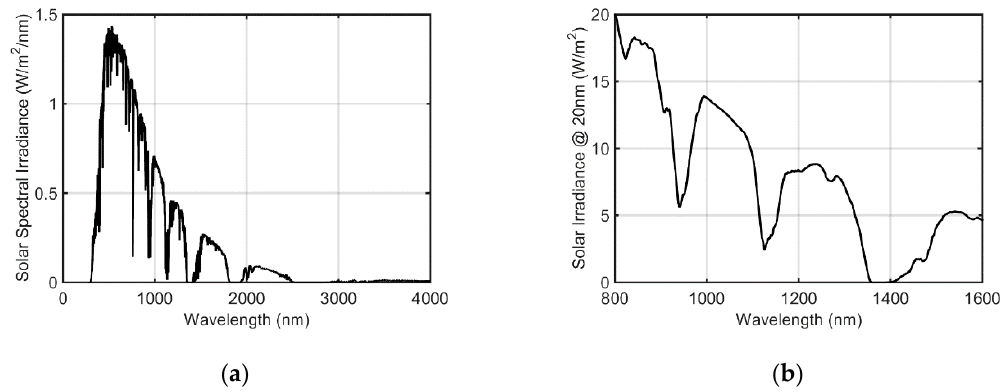
Figure 2. ( a ) Solar spectral irradiance (direct normal and circumsolar at AM 1.5) plotted, with permission, from G173-03 Standard Tables for Reference Solar Spectral Irradiances: Direct Normal and Hemispherical on 37° Tilted Surface, © ASTM International [46]; ( b ) Solar irradiance with 20 nm integration window.